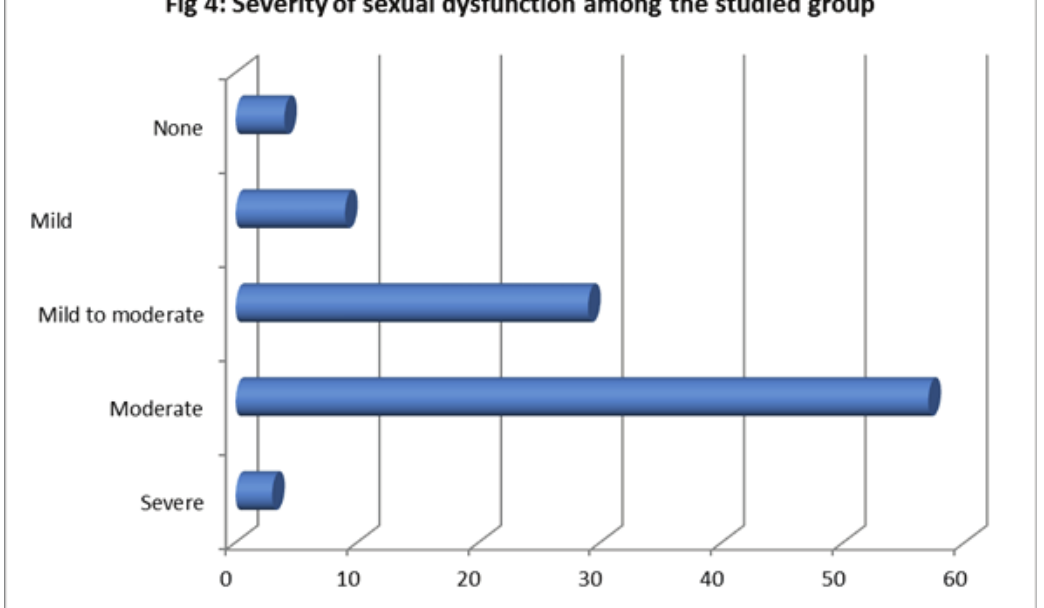
Figure 4: Severity of sexual dysfunction among the studied group (According to IIEF score).